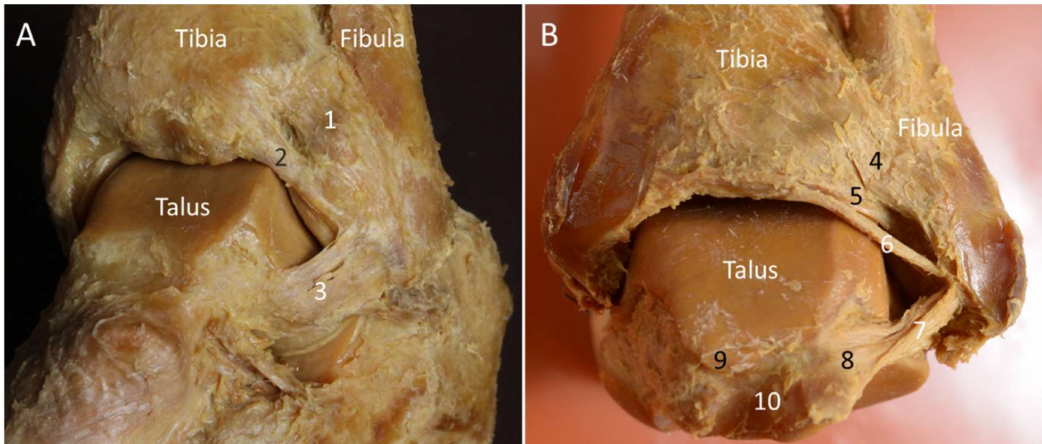
Figure 1. Lateral ( A ) and posterior ( B ) views of the ankle joint on the cadaveric model. 1: Anterior tibiofibular ligament; 2: Bassett’s ligament; 3: anterior talofibular ligament; 4: superficial component of the posterior tibiofibular ligament; 5: deep component of the posterior tibiofibular ligament; 6: intermalleolar ligament; 7: posterior talofibular ligament; 8: lateral tubercle of the posterior talar process; 9: medial tubercle of the posterior talar process; 10: tunnel for flexor hallucis